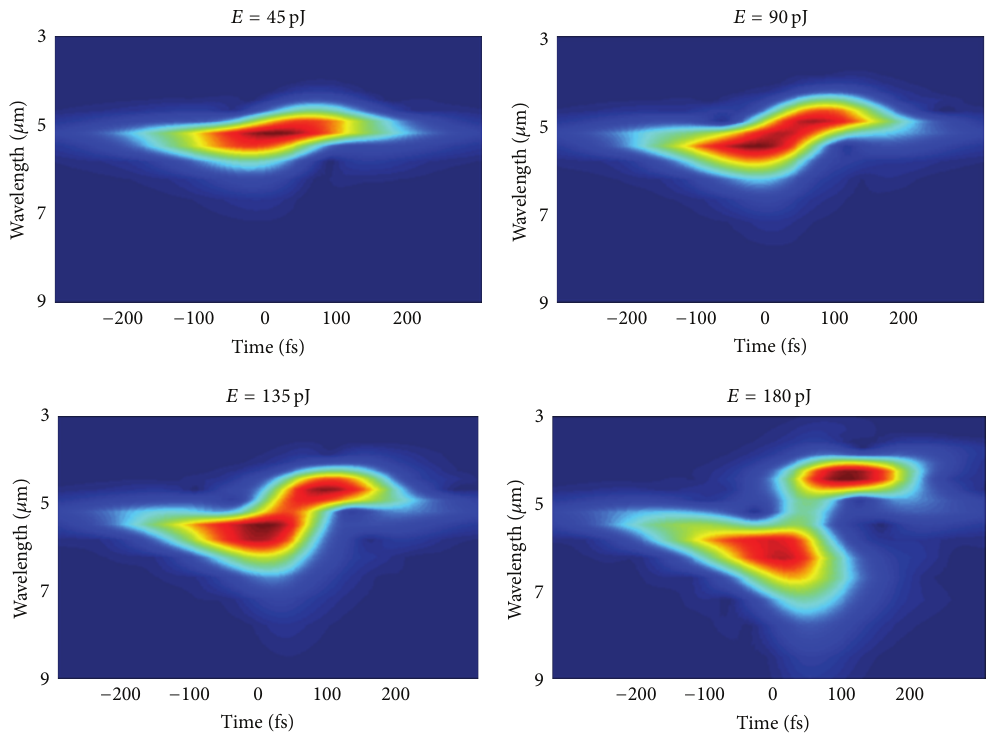
Figure5:SimulatedspectrogramrepresentationofthepulseevolutionatdifferentenergyinsidetheAs 2 Se 3 -basedPCFwithprojectedspectral intensity